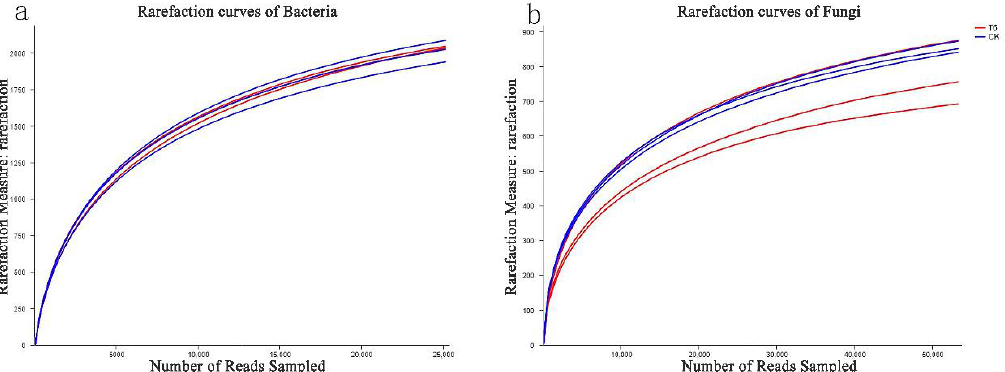
Figure 1. Rare-faction curves of ( a ) communities of bacteria and ( b ) fungi. The rare-faction curves exhibiting influences of a dissimilarity cut-off of 3% on OTUs numbers uncovered in the study groups. The T6-1 group consisted of poplar trees, which were exposed to bacterial zymotic fluid with T6-1. The CK group consisted of poplar trees, which were exposed to an equivalent volume of sterile zymotic fluid. We analyzed three replicates for every treatment.